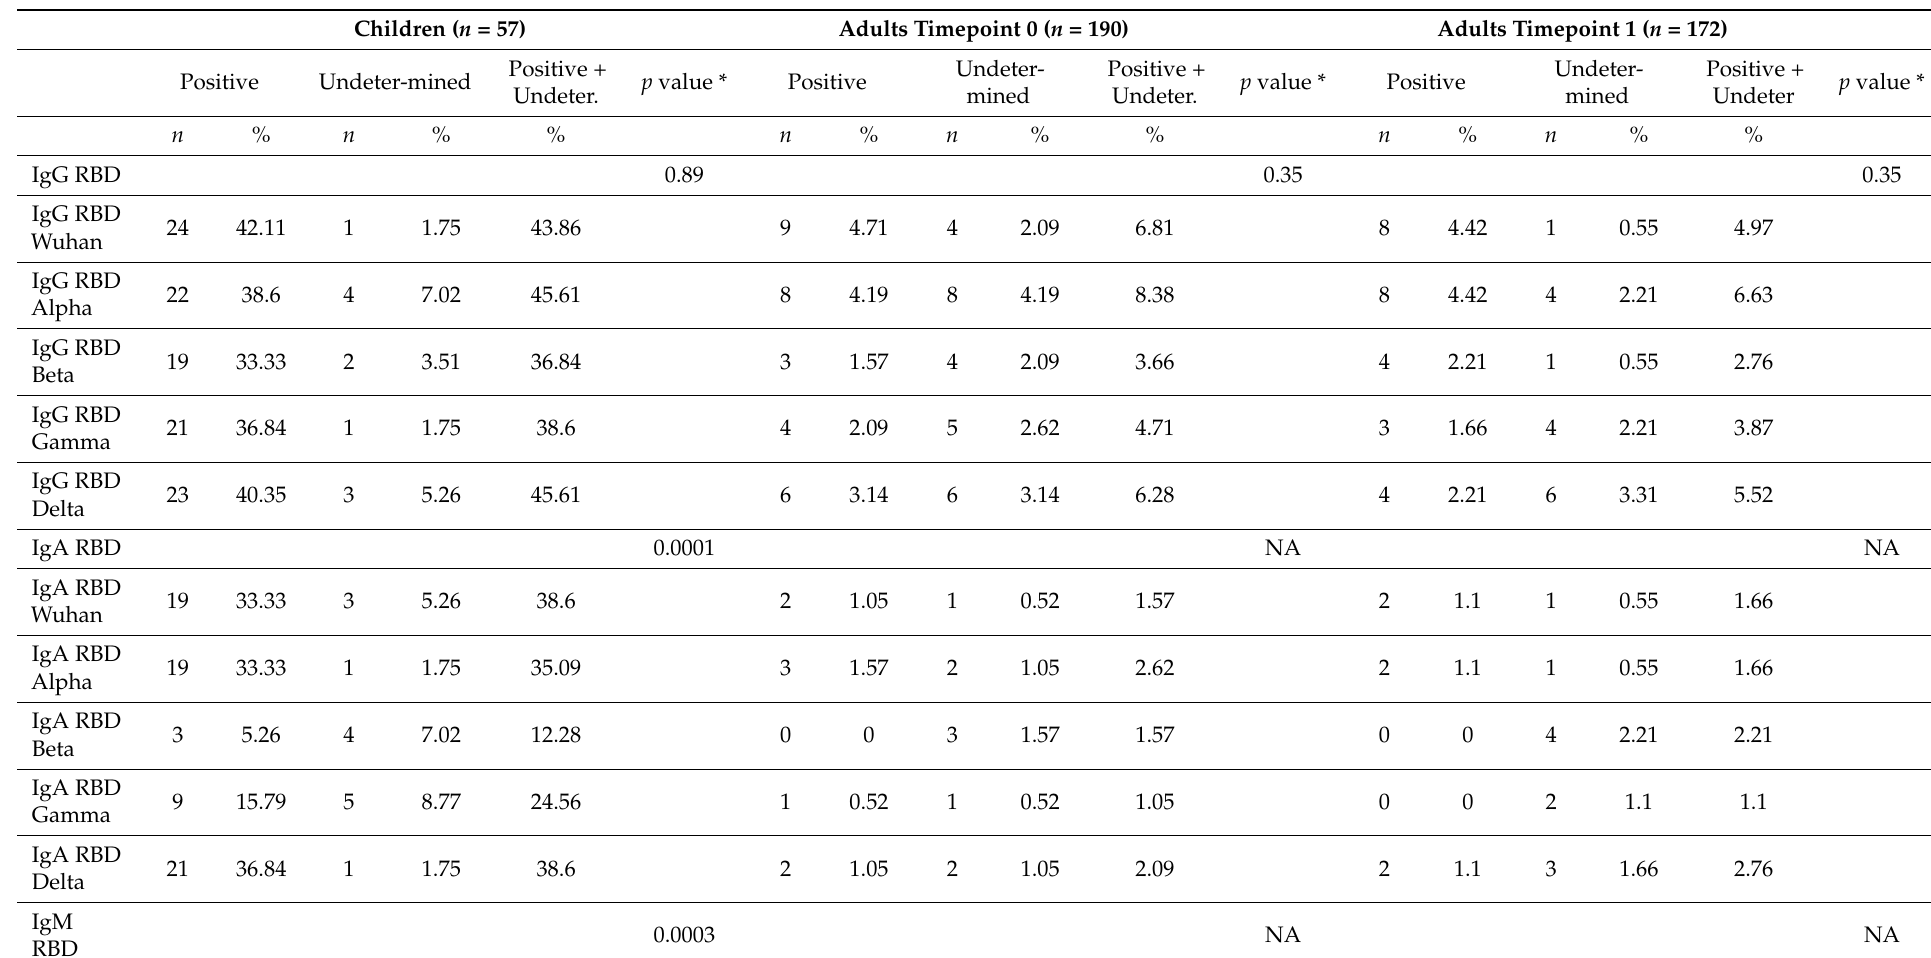
Table 3. Seroprevalence in study participants by isotype-RBD combination, including VoC RBDs (Alpha, Beta, Gamma and Delta), measured by